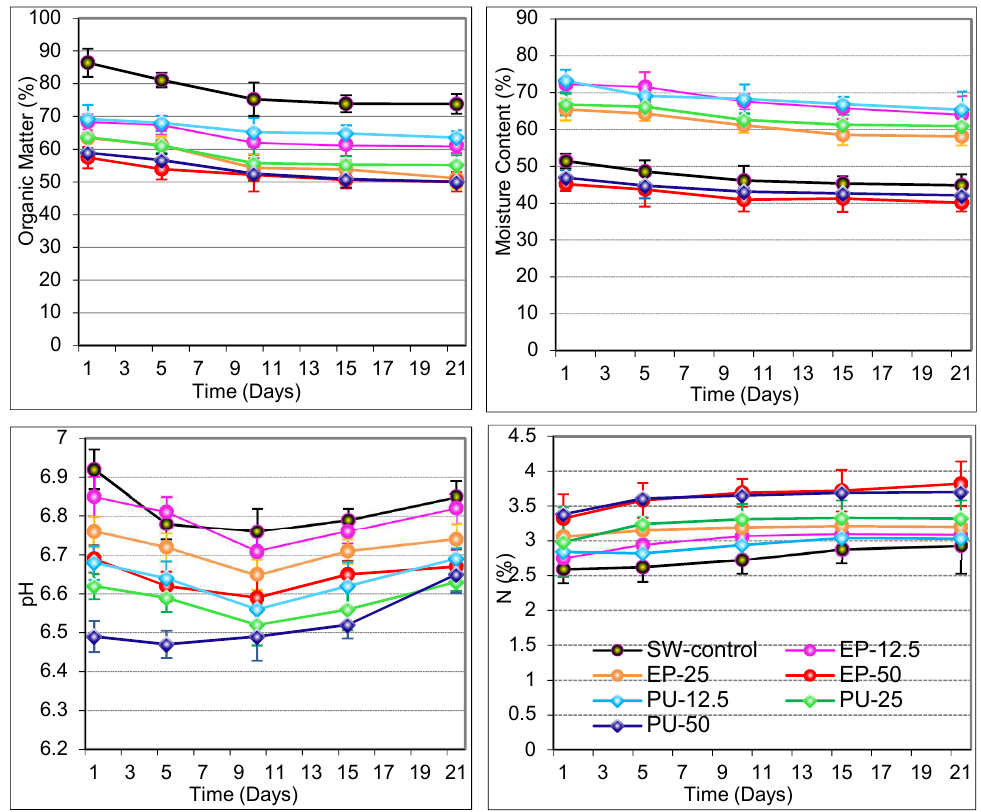
Figure 2. Variation of physicochemical parameters during sewage sludge composting mixed with inorganic porous bulking agents. Error bars represent the standard deviation for mean values of three replicates. SW sawdust, EP expanded perlite, and PU pumice at 12.5, 25, and 50% incorporation rate into compost mixture.